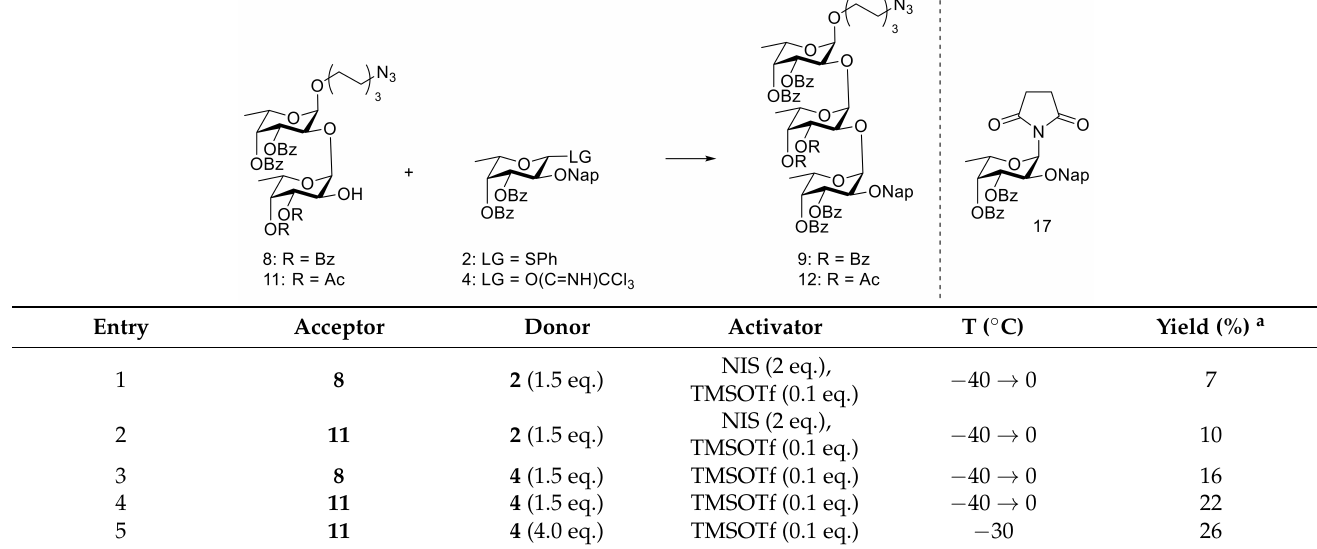
Table 1. Optimization of chain extension by variation of the C3-O’ and C4-O’ substituents of the acceptor.